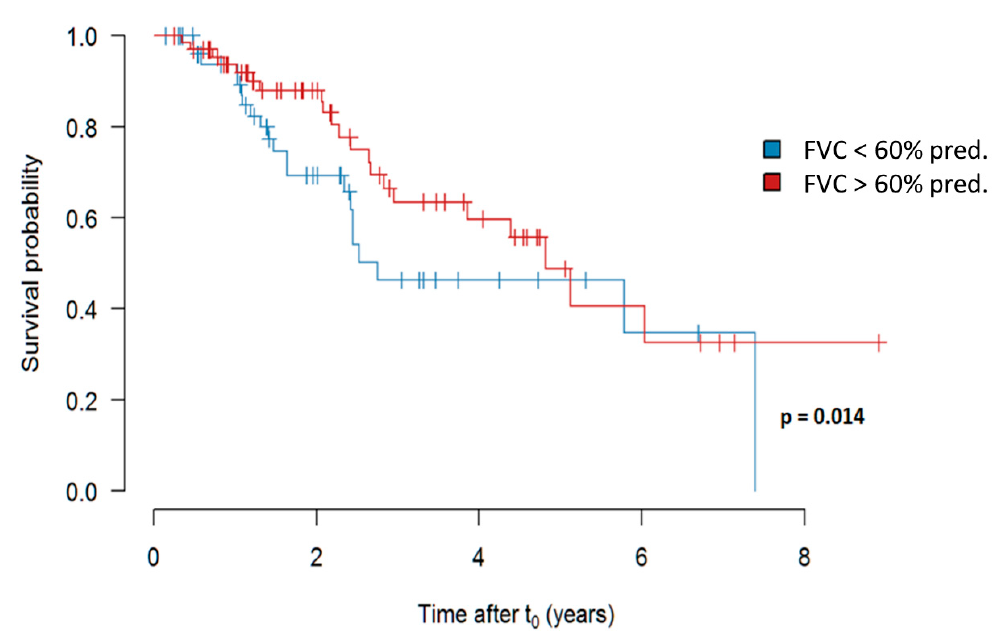
Figure 6 . Survival in dependency of an FVC more (in red) versus less (in blue) than 60% predicted at the time of initiation of pirfenidone treatment. Abbreviations: FVC — forced vital capacity. Survival Depending on GAP Stage at t0